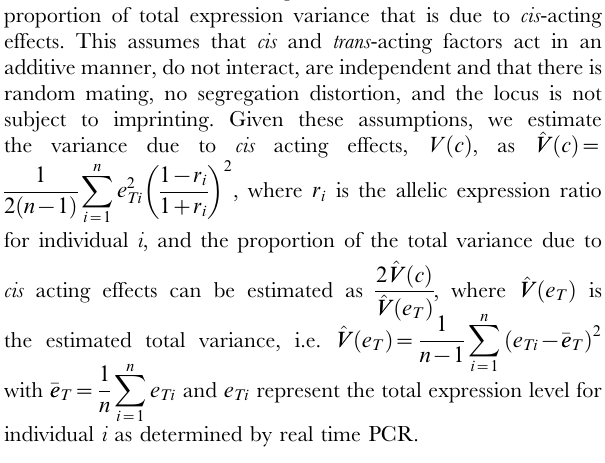
Figure S5 Correlation between AER in individuals heterozy- gous for both transcribed markers in a gene. The X- and Y-axes show the allelic expression ratio (AER) at the two transcribed SNPs in each gene. Each point represents an individual who is heterozygous for both transcribed SNPs in that gene. Circles represent CDKN2A , squares CDKN2B , and triangles ANRIL .